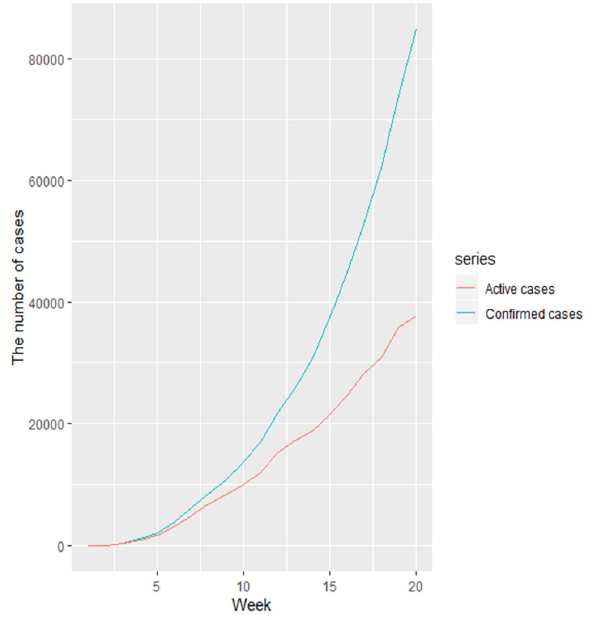
Fig. 1. The active and cumulative confirmed cases in Indonesia from March 7, 2020, until July 18,